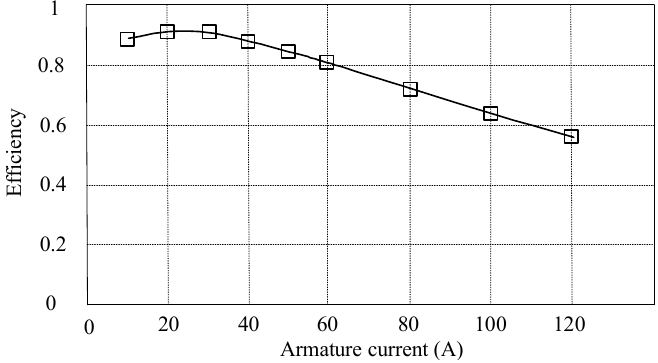
Figure 15. Variation of efficiency with armature current under rated speed condition.